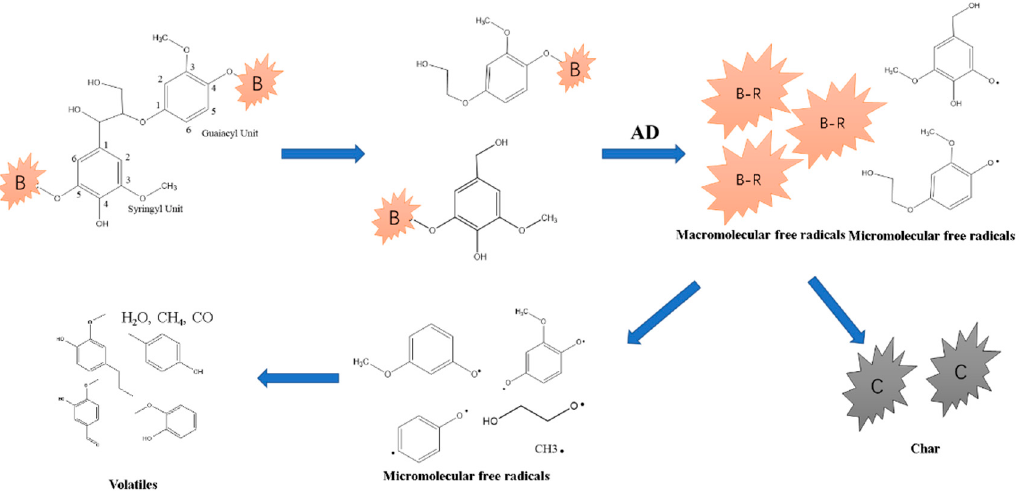
Figure 11. Scheme 3 for the formation of phenols from lignin catalyzed by AD.